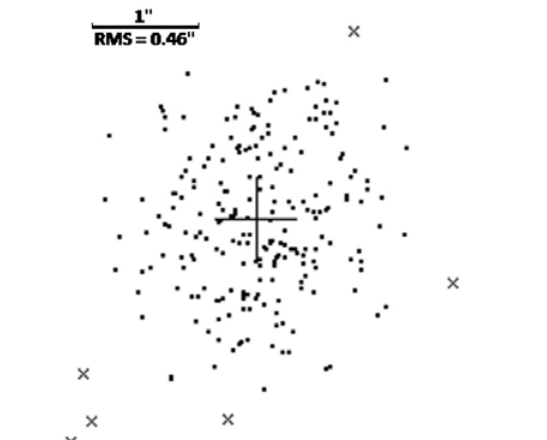
Fig. 4. Tiltmeter readings for a frame (sampling rate 10 per